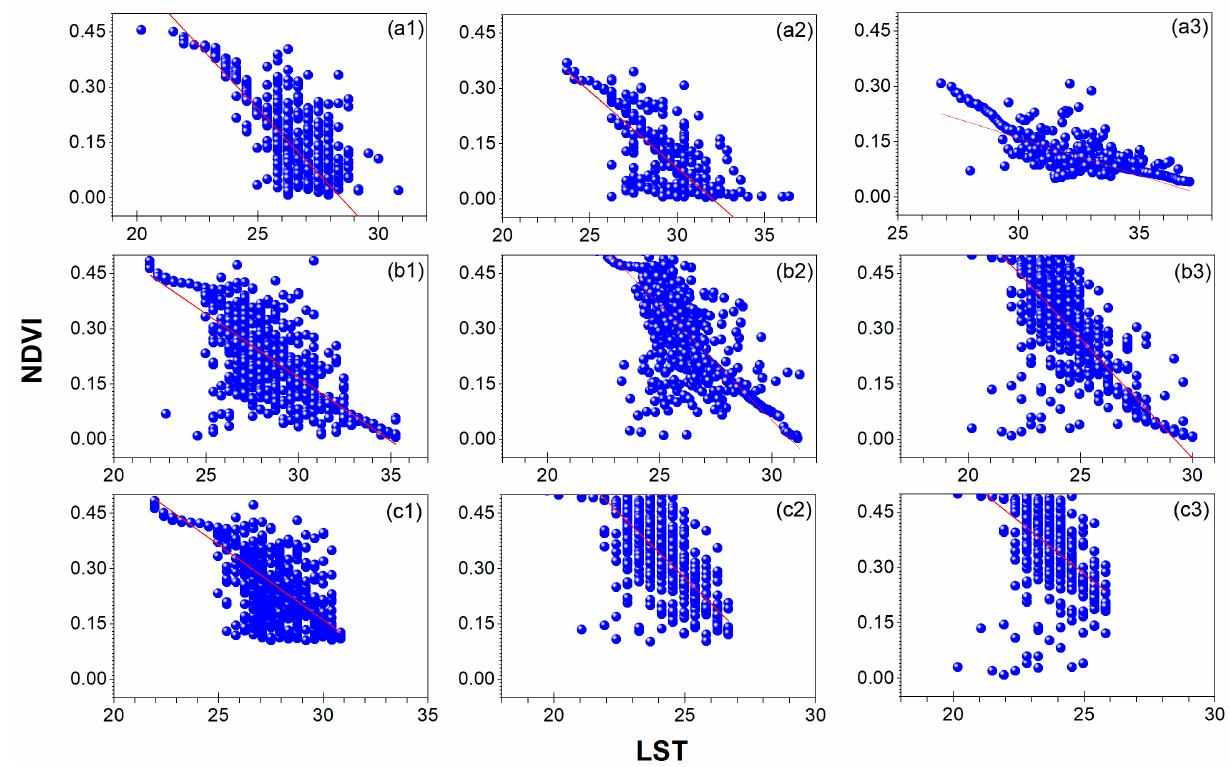
Figure 8. Correlation between LST and NDVI over the sample sites (a, b, and c). Note: ( a1 ) Peshawar 2000, ( a2 ) Peshawar 2010, ( a3 ) Peshawar 2020; ( b1 ) Swat 2000, ( b2 ) Swat 2010, ( b3 ) Swat 2020; ( c1 )